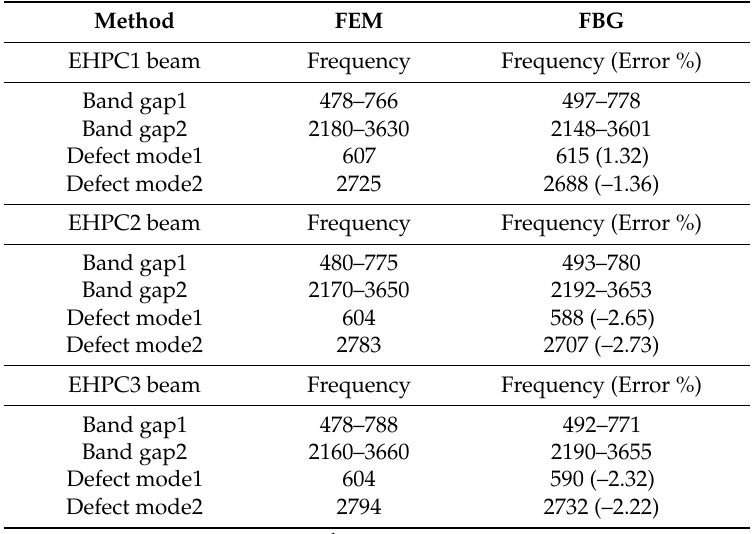
Table 1. Comparisons of the band gaps and defect modes obtained by the finite element method (FEM) and fiber Bragg grating (FBG) 1 .